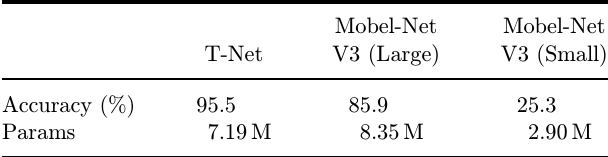
Table 2. The performance comparison of the model (T-Net) with the mobile-net V3.